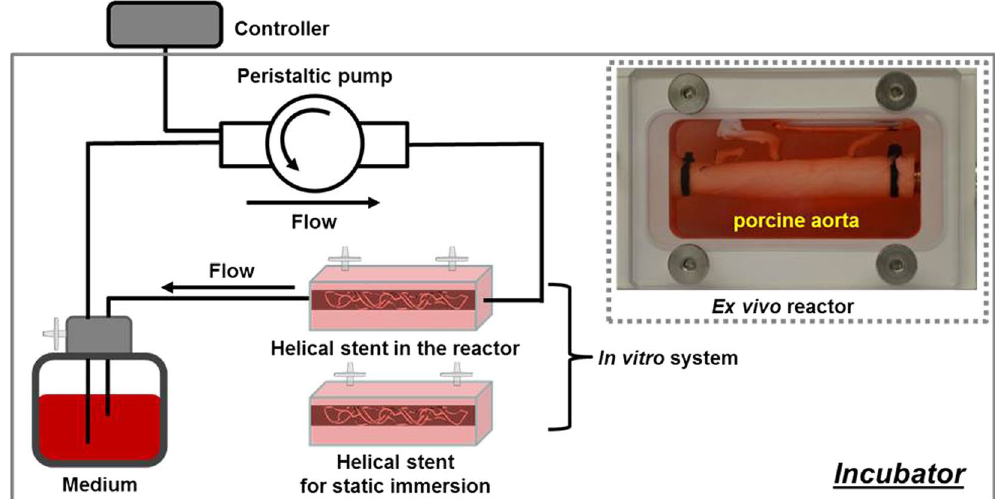
Figure 2. Bioreactor configuration for the in vitro and ex vivo simulation of the Mg-based helical stent.